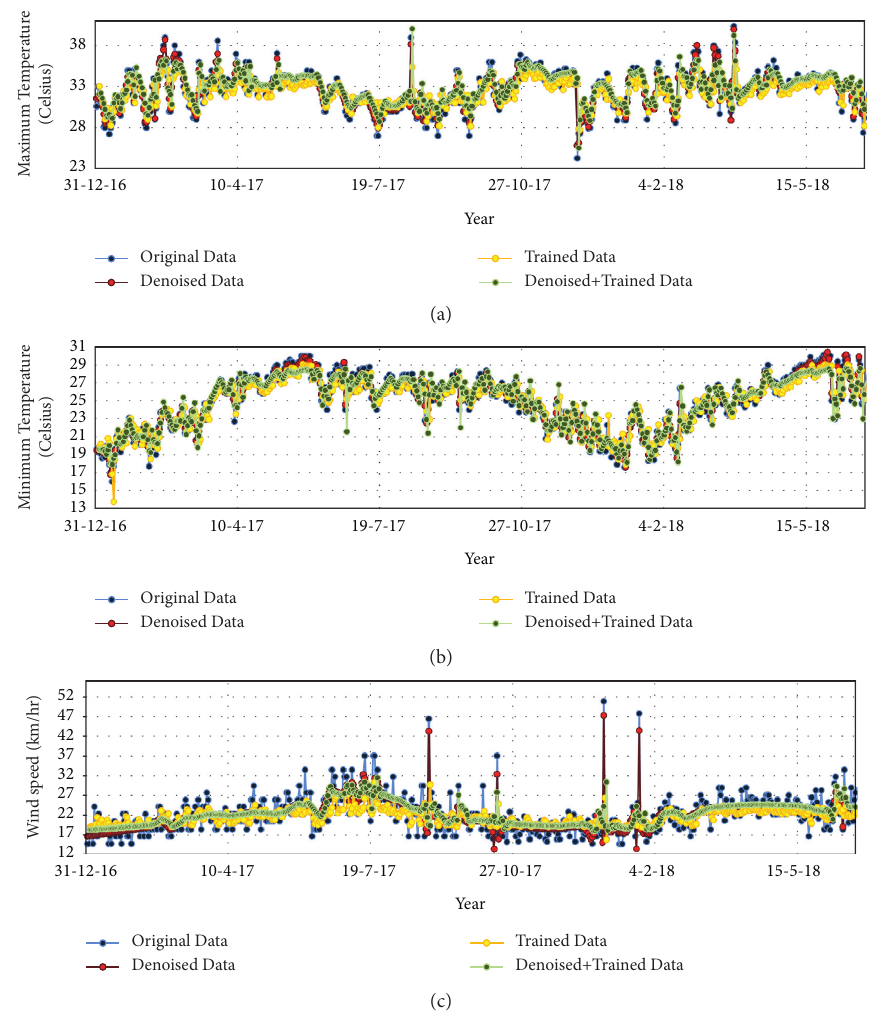
Figure 5: Original and denoised trained time series for Mumbai. (a) Maximum temperature data, Mumbai. (b) Minimum temperature data, Mumbai. (c) Wind speed data,